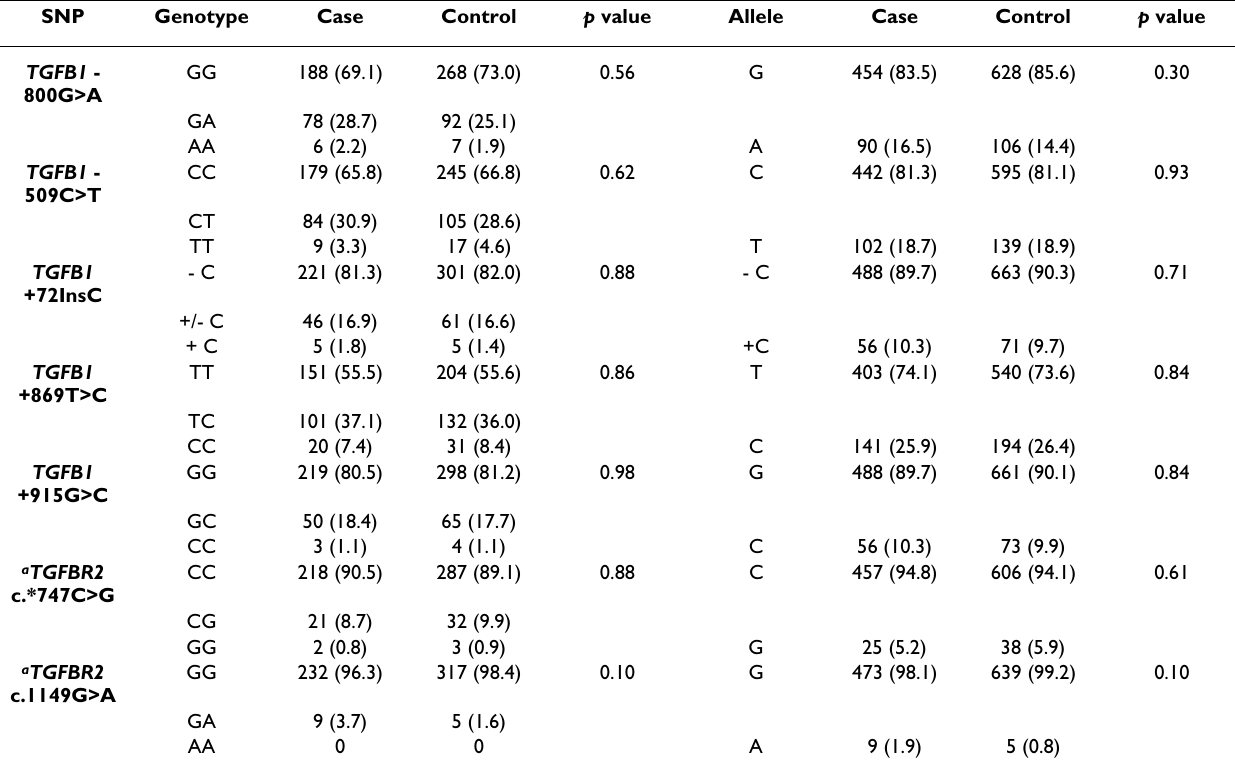
Table 7: Genotype and allele frequencies of selected SNPs in case and control groups. The five TGFB1 SNPs were selected on the basis of previous publications [23-27]. The remaining two TGFBR2 SNPs were selected from potentially functional SNPs identified through screening the gene as summarised in Table 1. Data are n